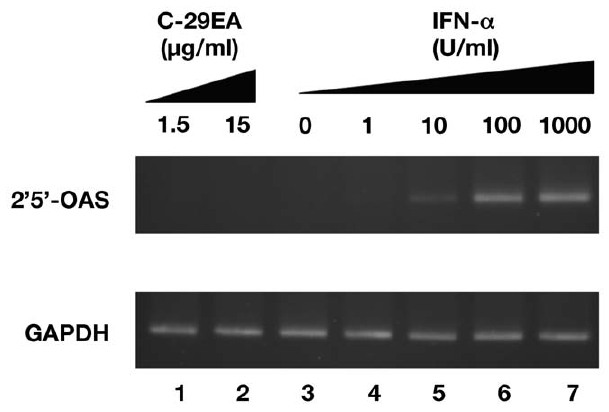
Figure 4. Effect of C-29EA on interferon signaling pathway. The Huh7 replicon cell line of genotype 1b was treated without (lane 3) or with 1, 10, 100, or 1000 U/mL interferon-alpha 2b (lanes 4–7), and 1.5 or 15 m g/ml C-29EA (lanes 1–2) for 48 h. Treatment with DMSO corresponds to ‘0 9 . The mRNAs of 2 9 , 5 9 -OAS, and GAPDH as an internal control were detected by RT-PCR. Error bars indicate standard deviation. The data represent three independent experiments.